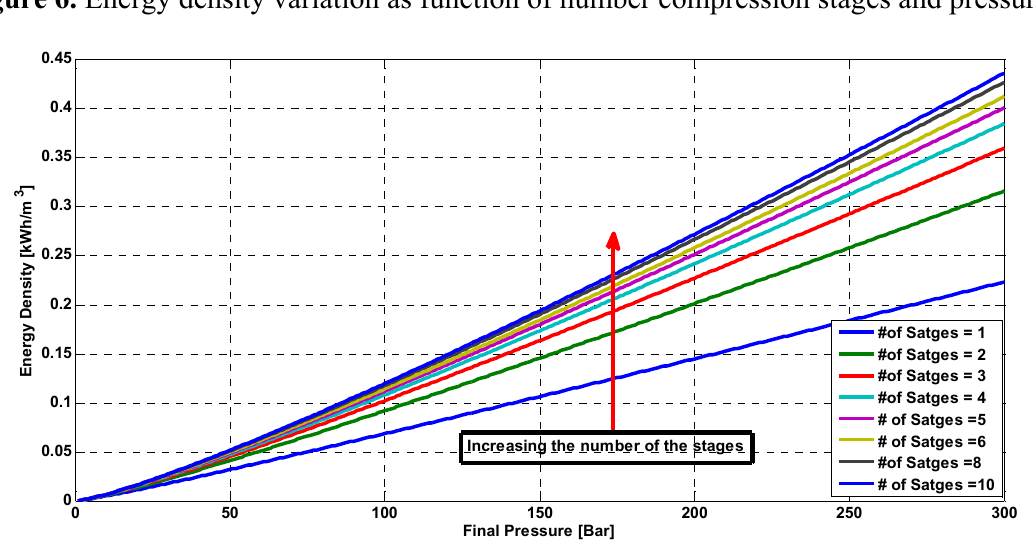
Figure 6. Energy density variation as function of number compression stages and pressure.